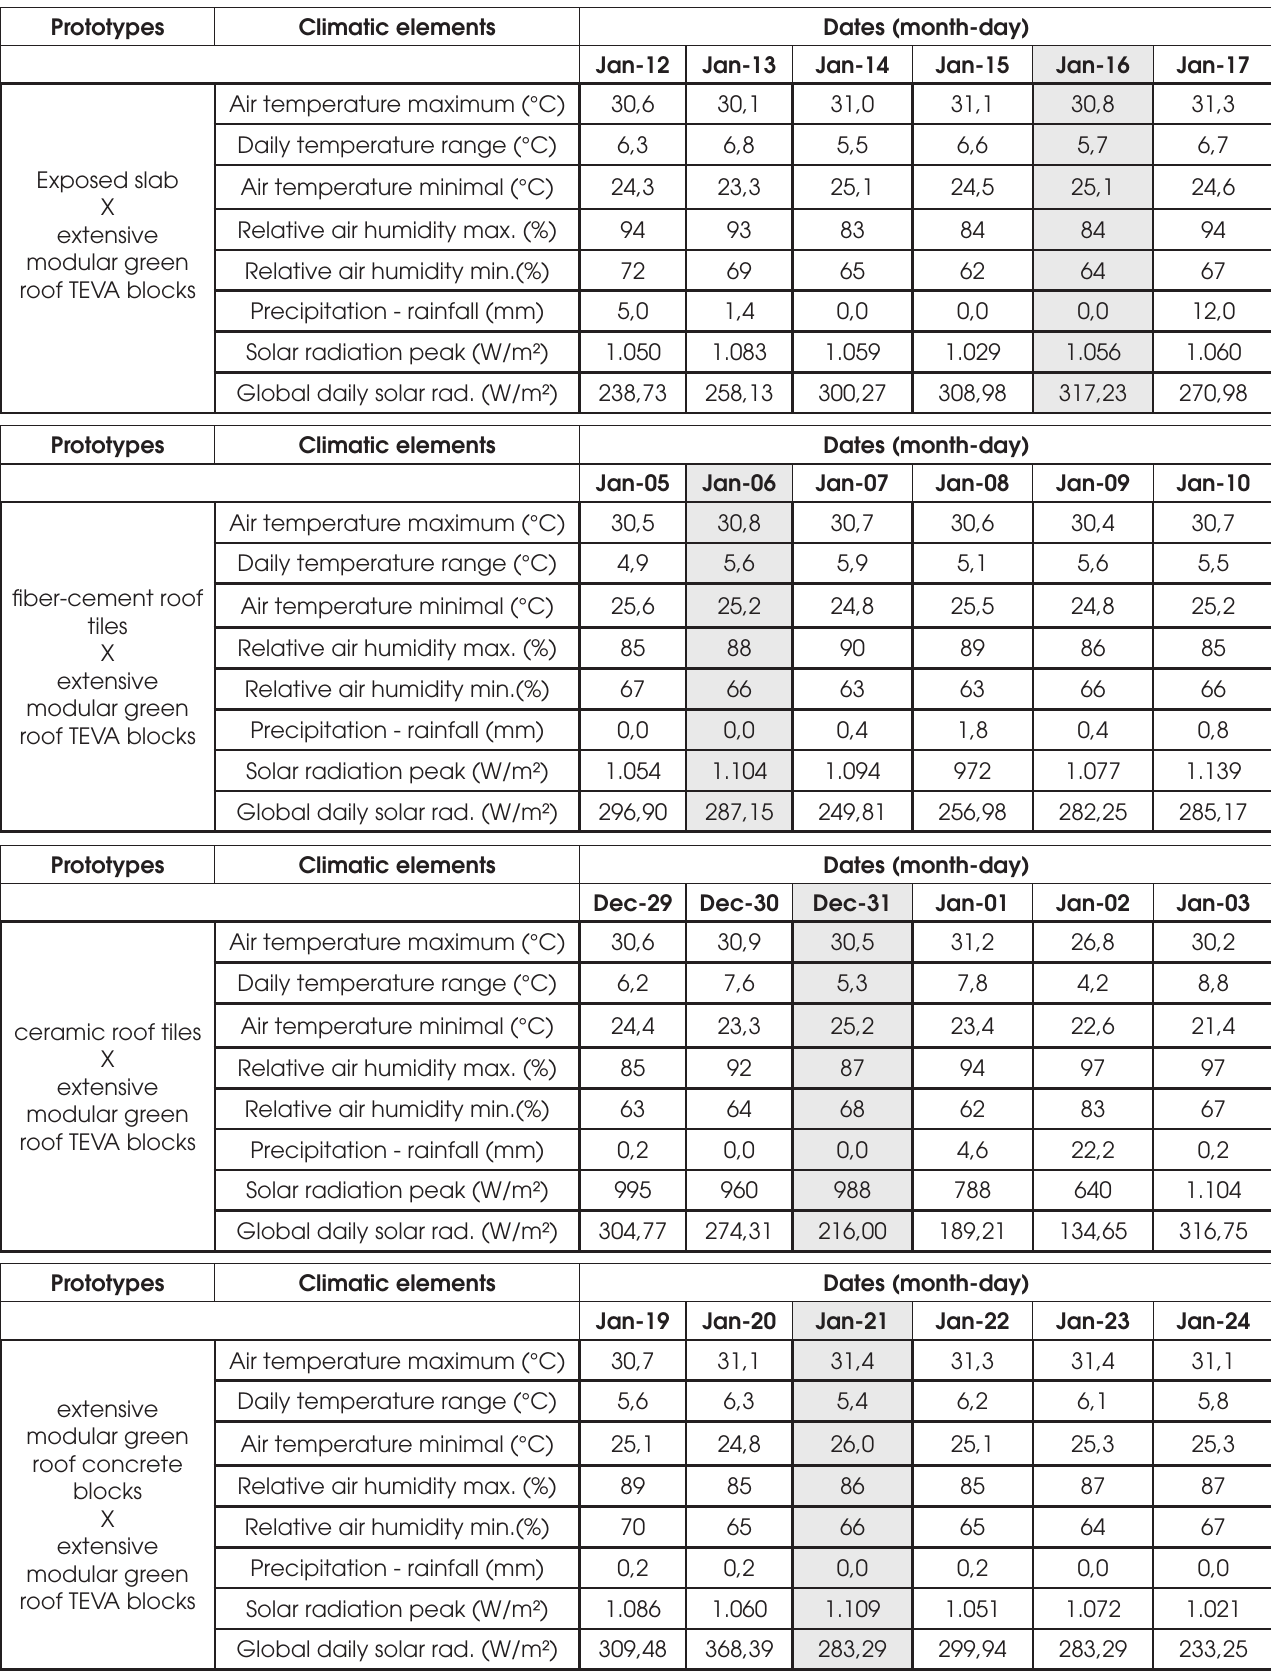
Climatic elements in the prototypes’ external environment, used to select the typical summer days (in bold and grey